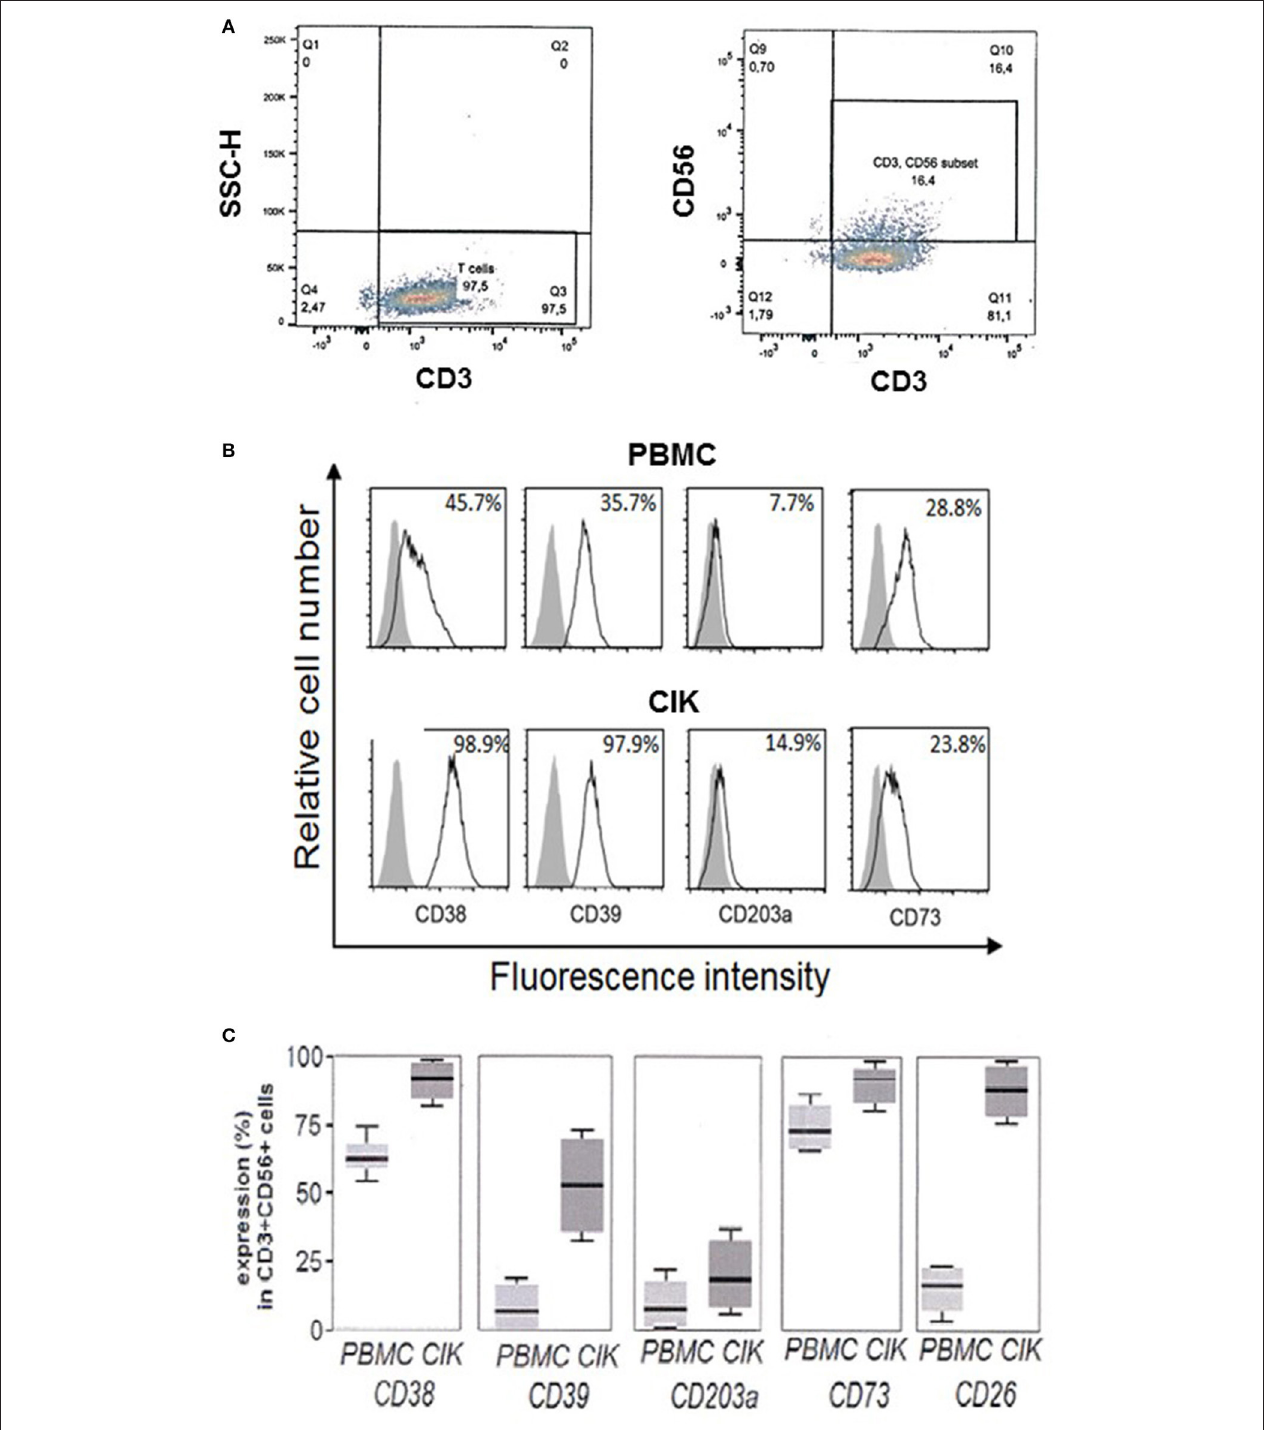
FIGURE 2 | Expression of CD38, CD39, CD203a, and CD73 in CD3 + CD56 + human PBMC and in the corresponding CIK cells. (A) Representative gating of CD3 + and CD3 + CD56 + populations present in CIK cells at the third week of culture. Analysis was performed by using the fluorophores PE-Cy7 or FITC for CD3 and CD56 antigens, respectively. (B) Cytofluorometric expression analysis of ectoenzymes (white peaks) in PBMC at day 0 (upper panel) and CIK cells at day 21 (lower panel). CD38, CD39, CD73, and CD203a were detected by APC conjugated antibodies. Gray peaks demarcate isotype control staining. Percentage of positive cells is indicated. (C) Percentage of expression of the different markers in PBMC (day 0) and CIK cells (day 21). Cells were from 6 subjects (5 gastrointestinal stromal tumors and 1 osteosarcoma). In C , data are expressed as mean, minimum and maximum values.